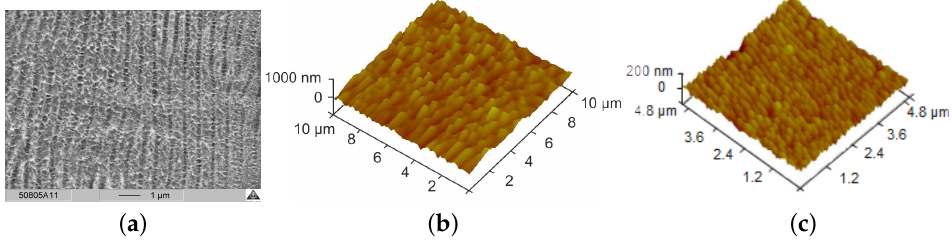
Figure 2. SEM ( a ) and AFM images of nanostructured titanium foil ( b ) and AFM image of nanostructured Si 3 N 4 ( c